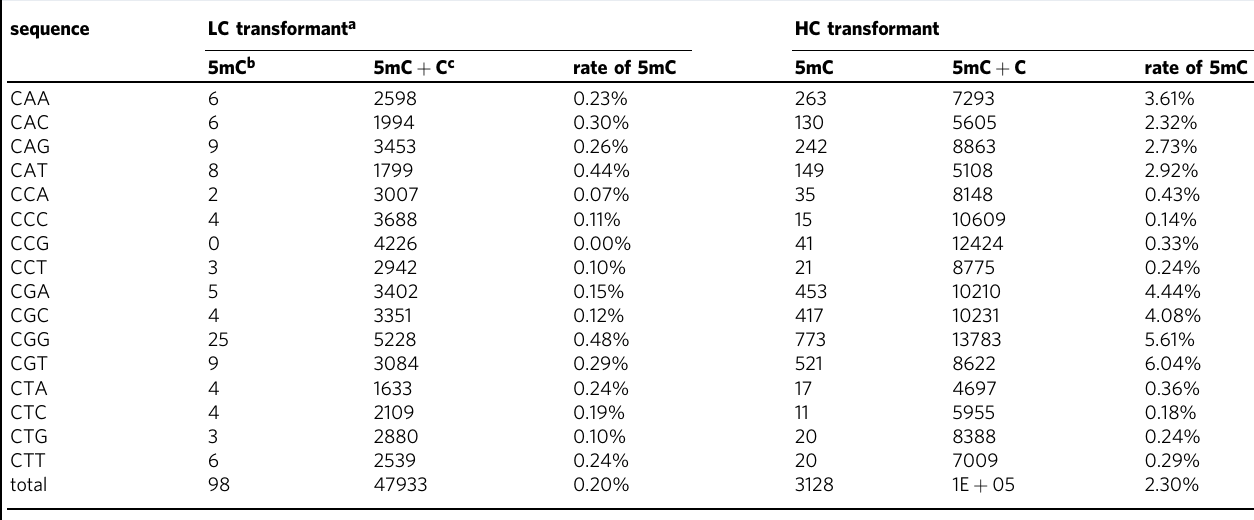
a Transformants with ~2 copies (low copy, LC) and 10 copies (high copy, HC) of MGY- Δ RT. b Total number of 5mC within a sequence context in mapped reads (original sequence). c Total number of a sequence context occurred on both strands in mapped reads (original